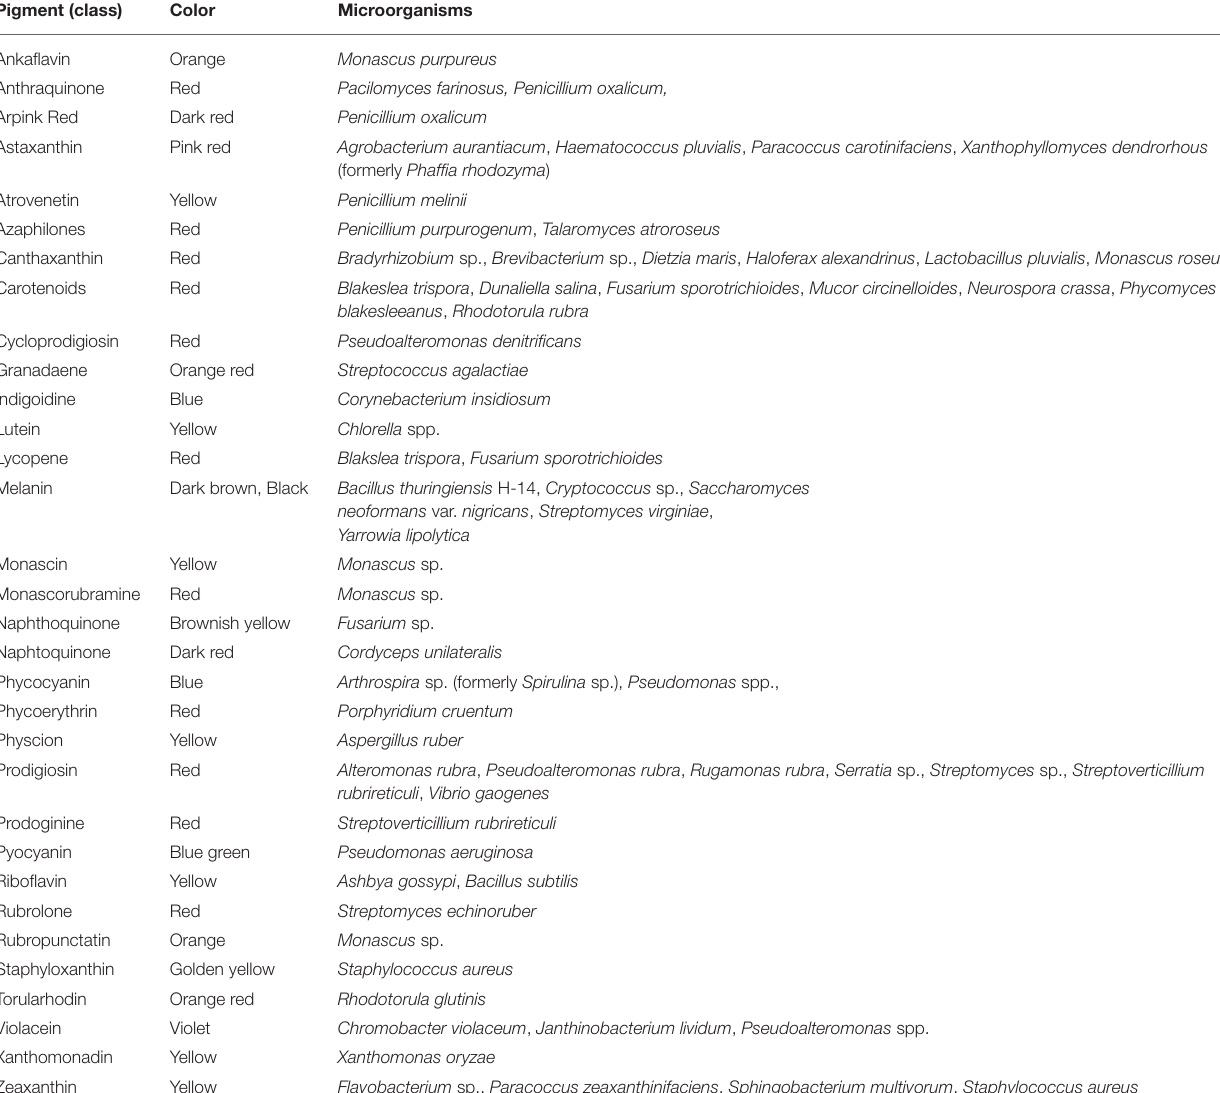
TABLE 1 | Microbial pigments and their source organisms [based on data from Malik et al. (2012), Panesar et al. (2015), Lagashetti et al. (2019), and Sen et al. (2019)]. Pigment